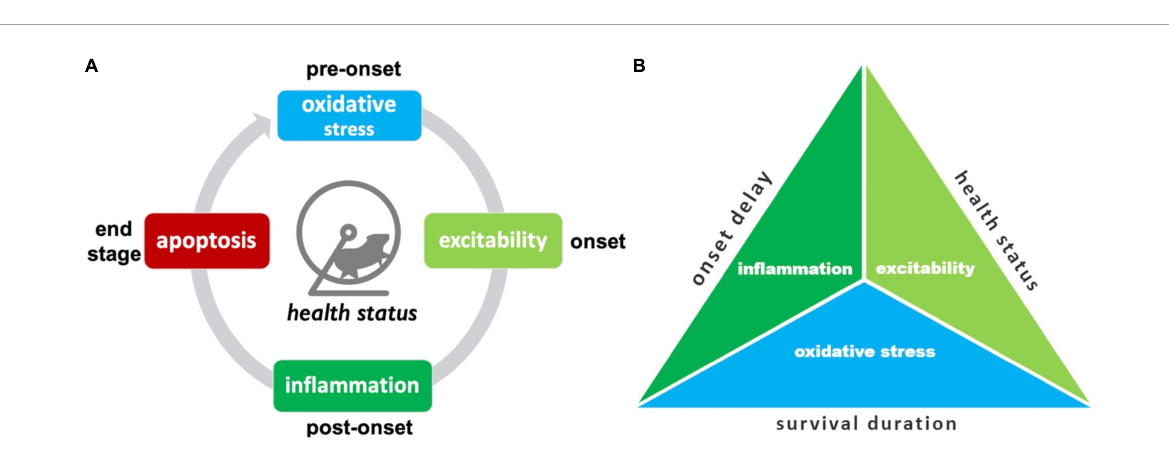
FIGURE8 Summary of top SOD1 G93A pathophysiological treatment category performers. (A) The “best” pathophysiological category for maintaining health status (rotarod, grip strength, body weight, etc.) changes with disease progression. (B) Triad illustrating the best overall treatment performers based on three different assessment modalities. Oxidative stress treatments best delay onset. Excitability treatments were best overall for maintaining health status and/or delaying functional decline. Oxidative stress treatments were best for prolonging survival